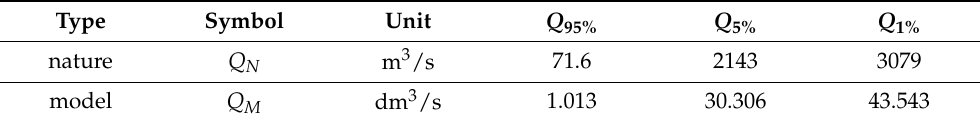
Table 5. Recalculation of discharges for the physical